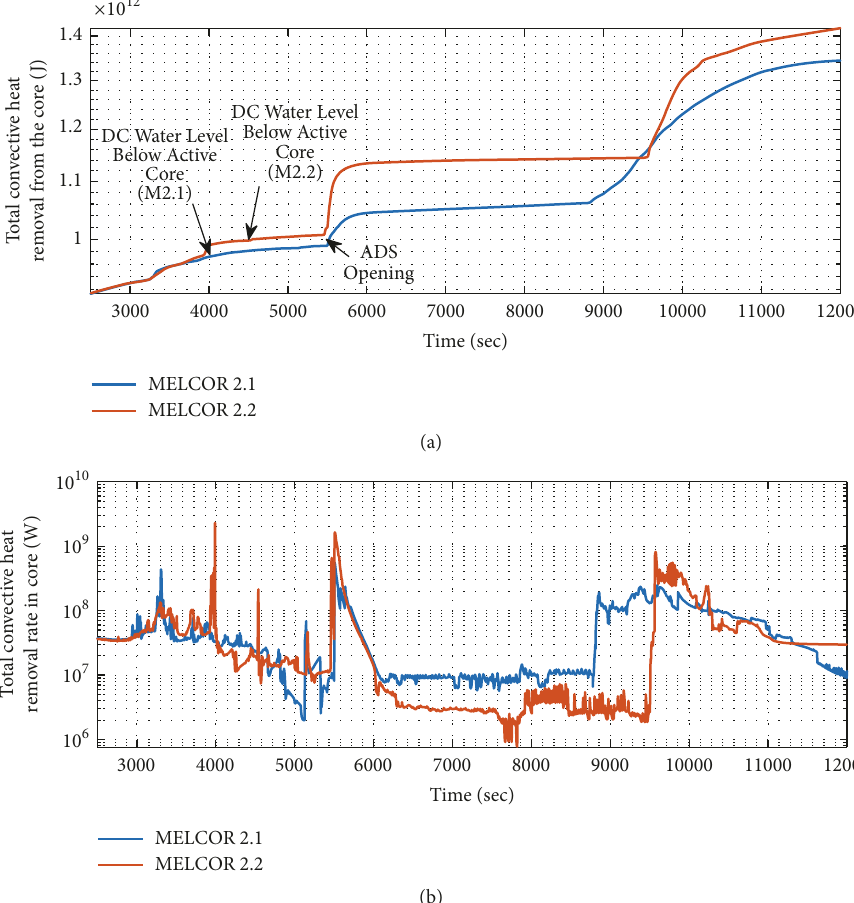
Figure 16: MELCOR 2.1 and 2.2 predictions of (a) total convective heat removal from the core (J) and (b) total convective hear removal rate in core